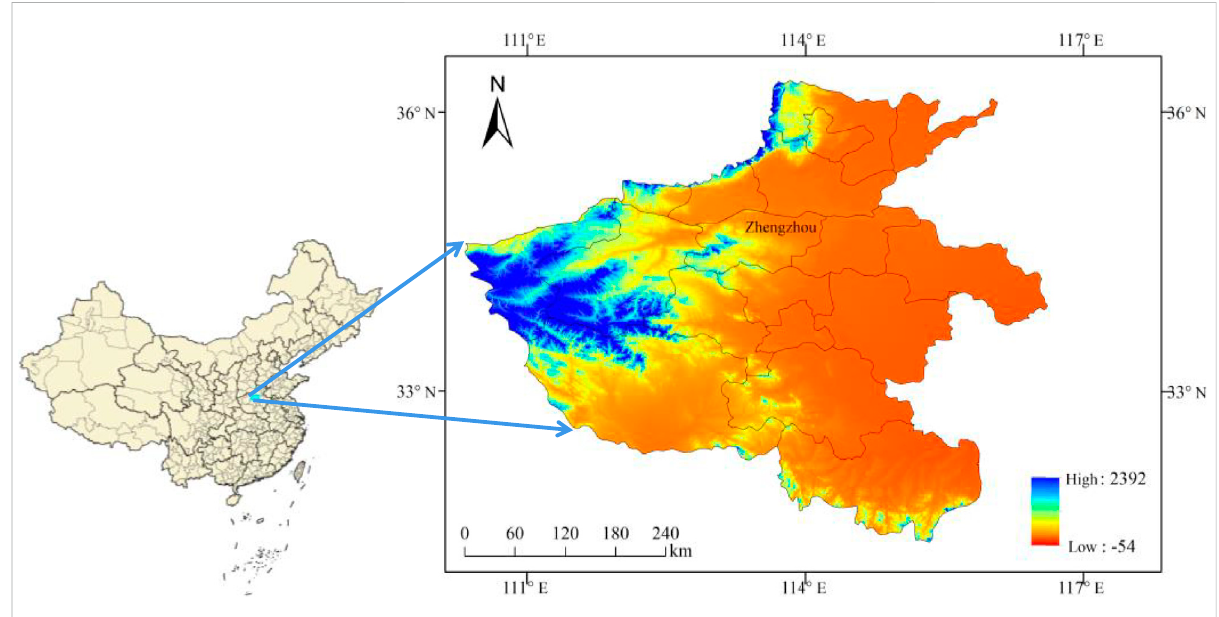
FIGURE 1 The location and surrounding landform of Zhengzhou (The unit on the color contour is